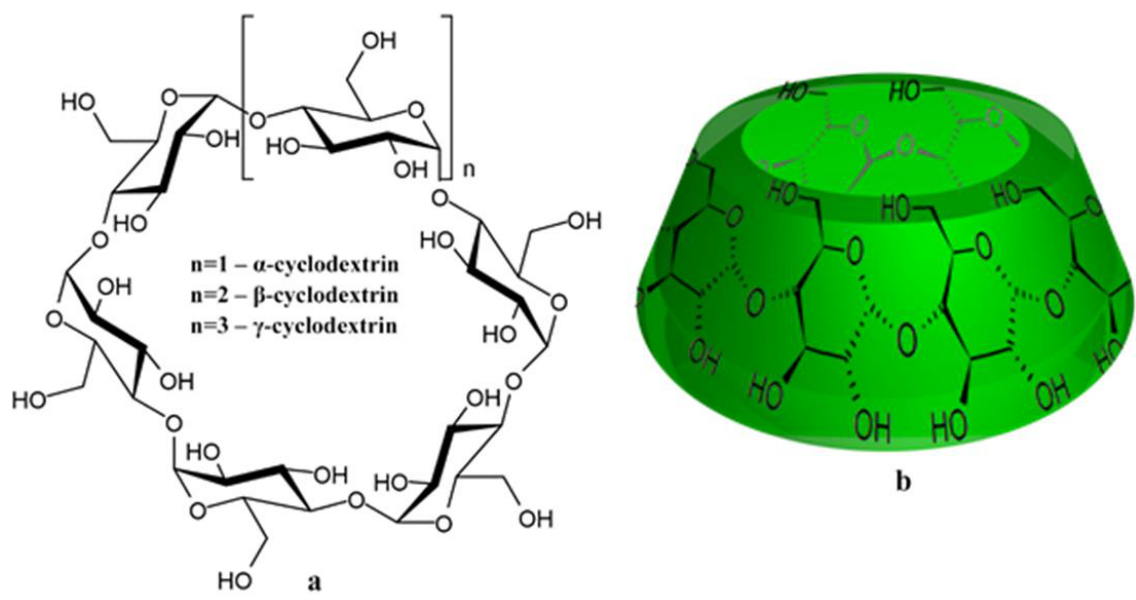
Figure 2. ( a ) Structural formula of cyclodextrins; ( b ) 3D structure of